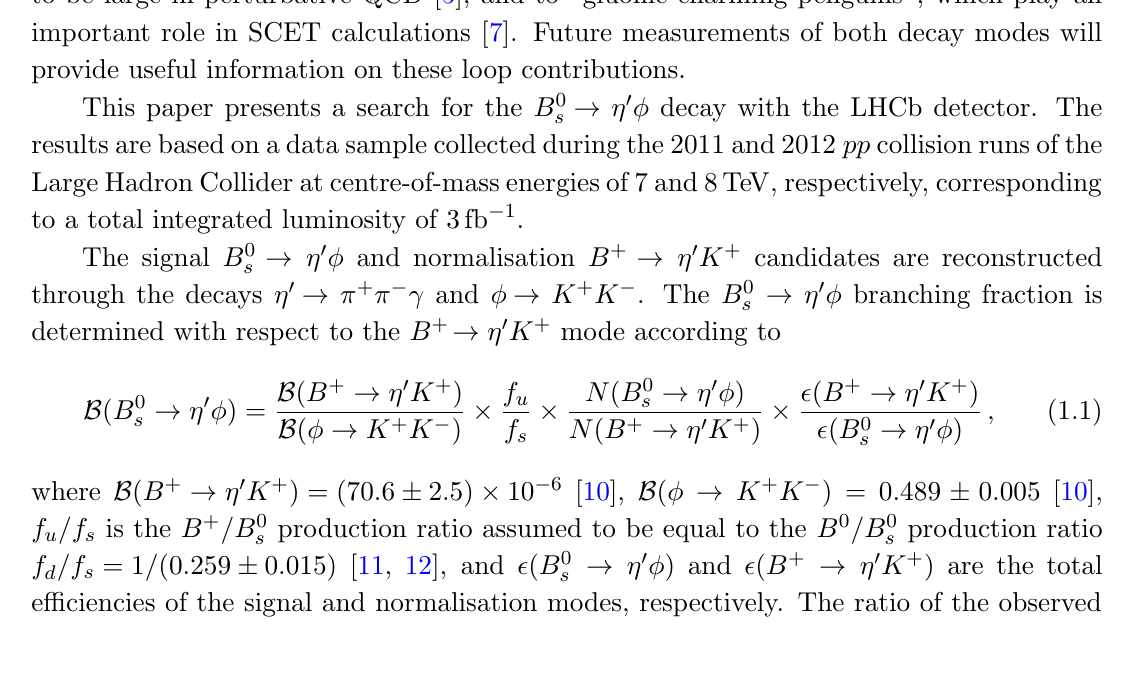
(cid:17) 0 (cid:30) decay. The spectator quark can become s !